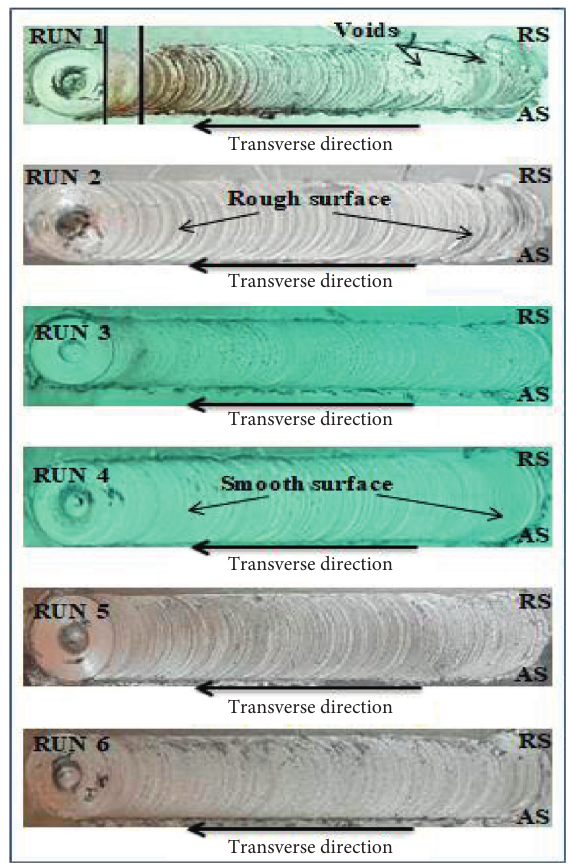
Figure 6: Visual representation of welded composite